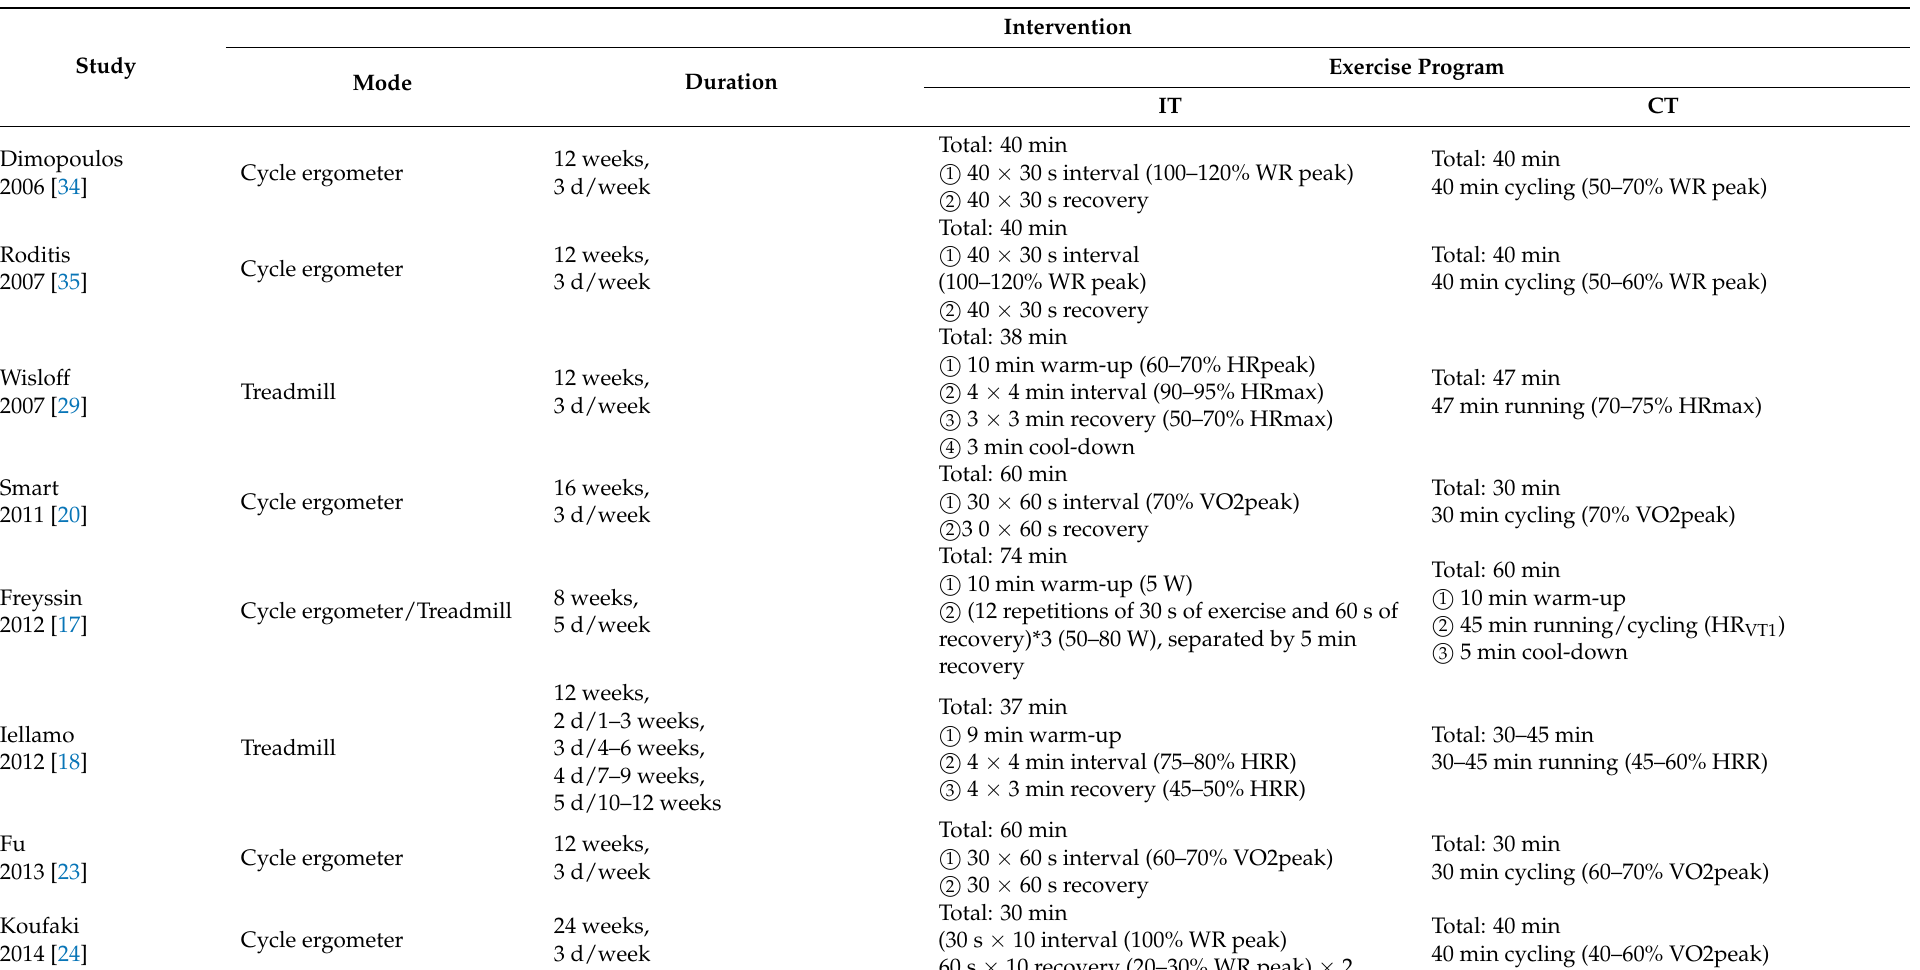
Table 2. Characteristics of the studies included in the meta-analysis (intervention